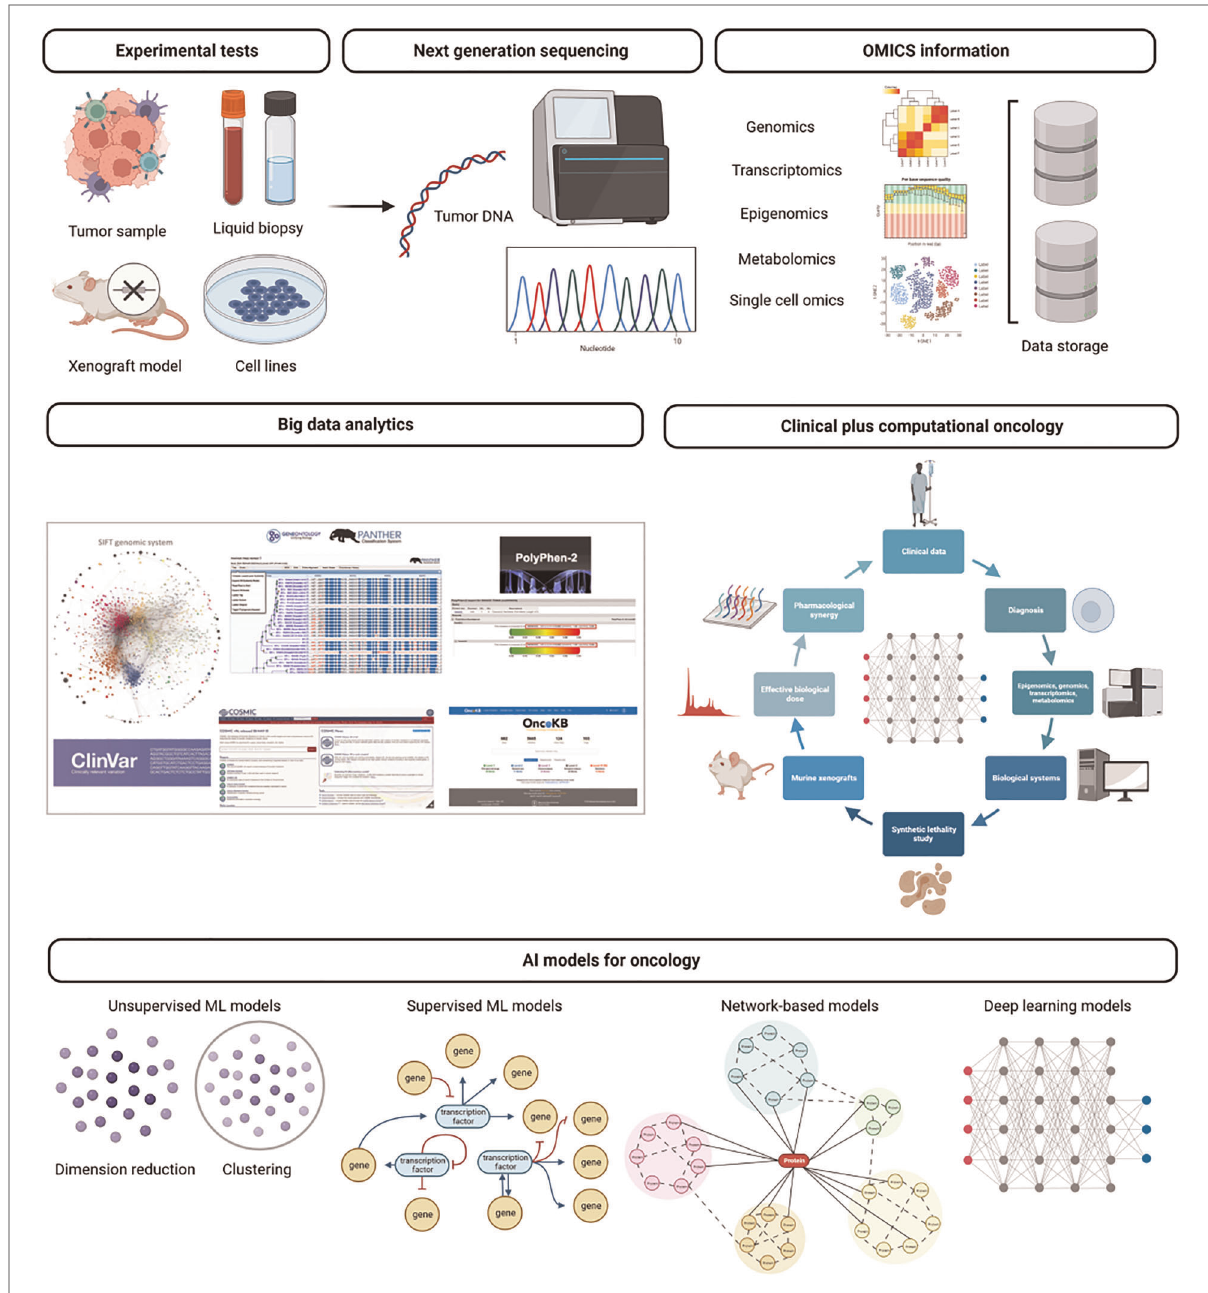
FIGURE 1 General application of arti fi cial intelligence to genomics. Next-generation sequencing (NGS) data comes from genomics, transcriptomics, epigenomics, or single-cell omics. These approaches led to an accumulation of large-scale datasets to solve challenges of cancer research, molecular characterization, tumor heterogeneity, and drug target discovery. As the large scale of omics data accumulated, various machine learning techniques, including graph algorithms and deep neural networks, are applied for dimensionality reduction, clustering, or classi fi